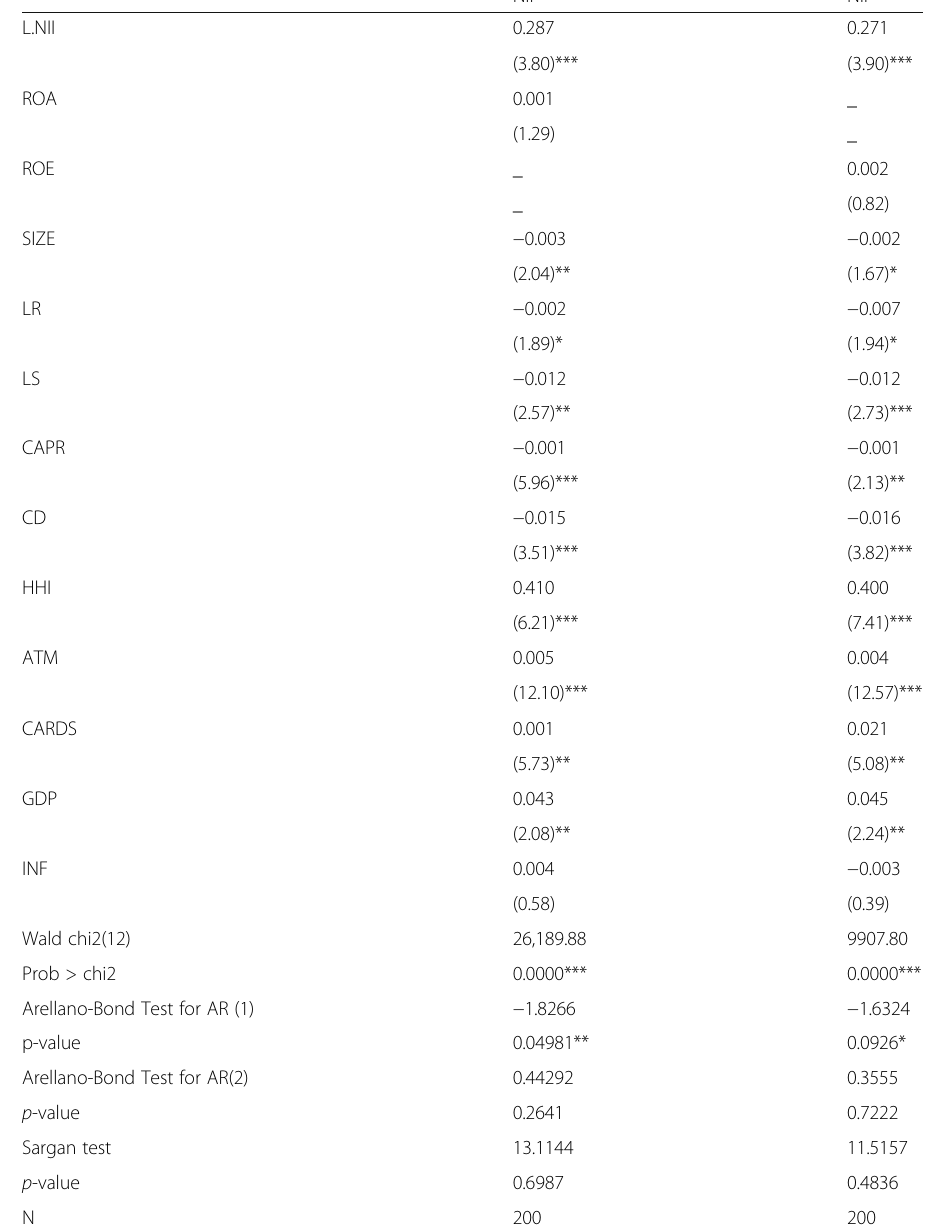
Table 4 Determinants of non-interest